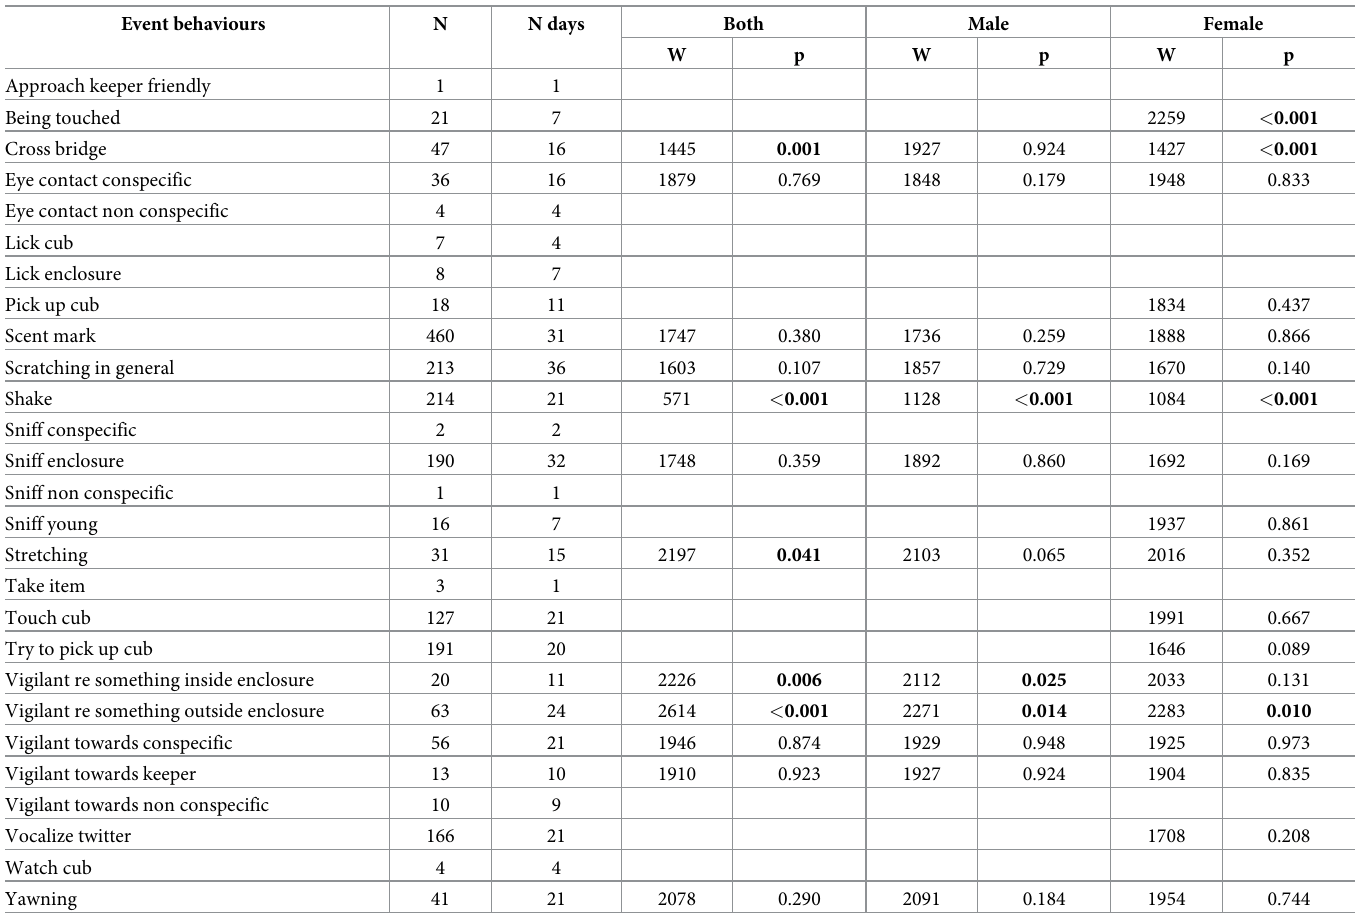
Table 2. Frequency of observation and results of Wilcoxon test event